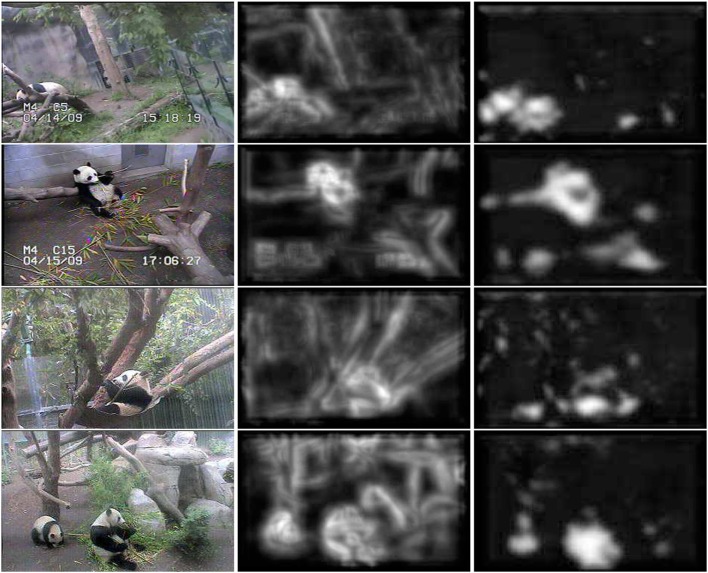
Localization of panda bears in a complex environment. Left: bear images. Note the highly variable pose of the bears and the strongly textured backgrounds. Center: saliency maps produced by a single layer HSDN. Right: saliency maps produced by a two-layer HDSN. The ability of the second network layer to learn discriminant saliency patterns reduces the number of false positives and enables significantly superior target localization.